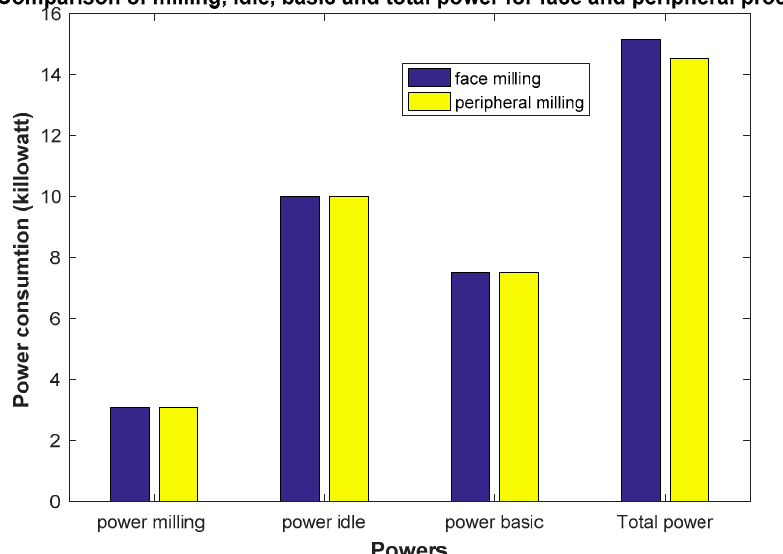
Figure 7. Comparison of milling, idle, basic and total power for face and peripheral process.